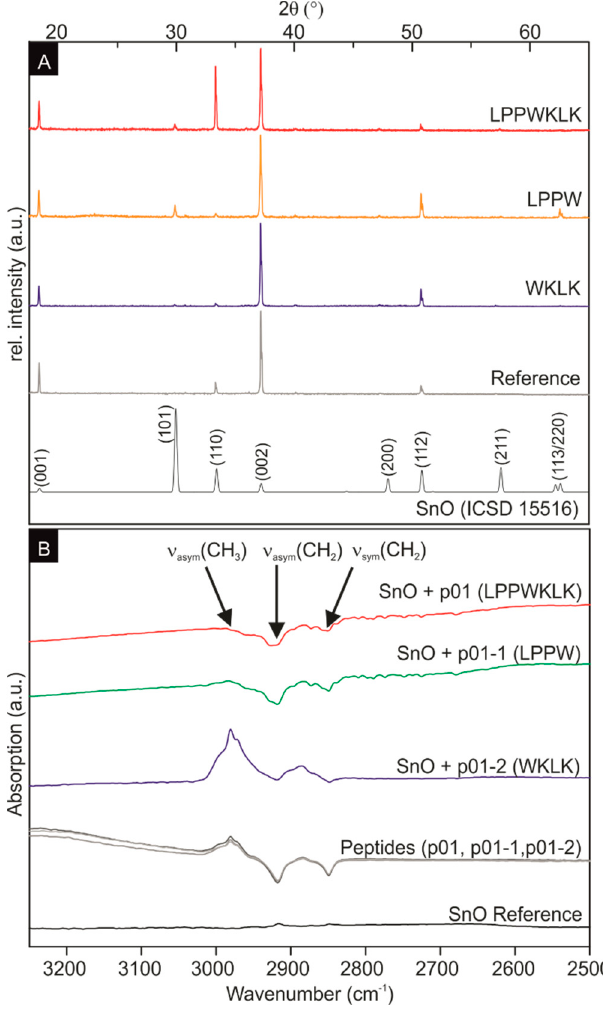
Figure 3. ( A ) SnO powder X-ray diffraction data. The powder X-ray data of crystalline SnO (ICSD 260 15516) [26] served as a reference. The strong texturation of the measured X-ray spectra is caused by 261 the platelet shape and sample preparation for the measurement. ( B ) FTIR spectra of the SnO reference 262 without peptides (black), the three peptides (SnBP01, SnBP01-1, SnBP01-2) in solution (grey curves), 263 the SnO structures with SnBP01-2 (WKLK) (blue), the SnO structures with SnBP01-1 (LPPW) (green), 264 and the SnO structures with SnBP01 (LPPWKLK) (red). 265